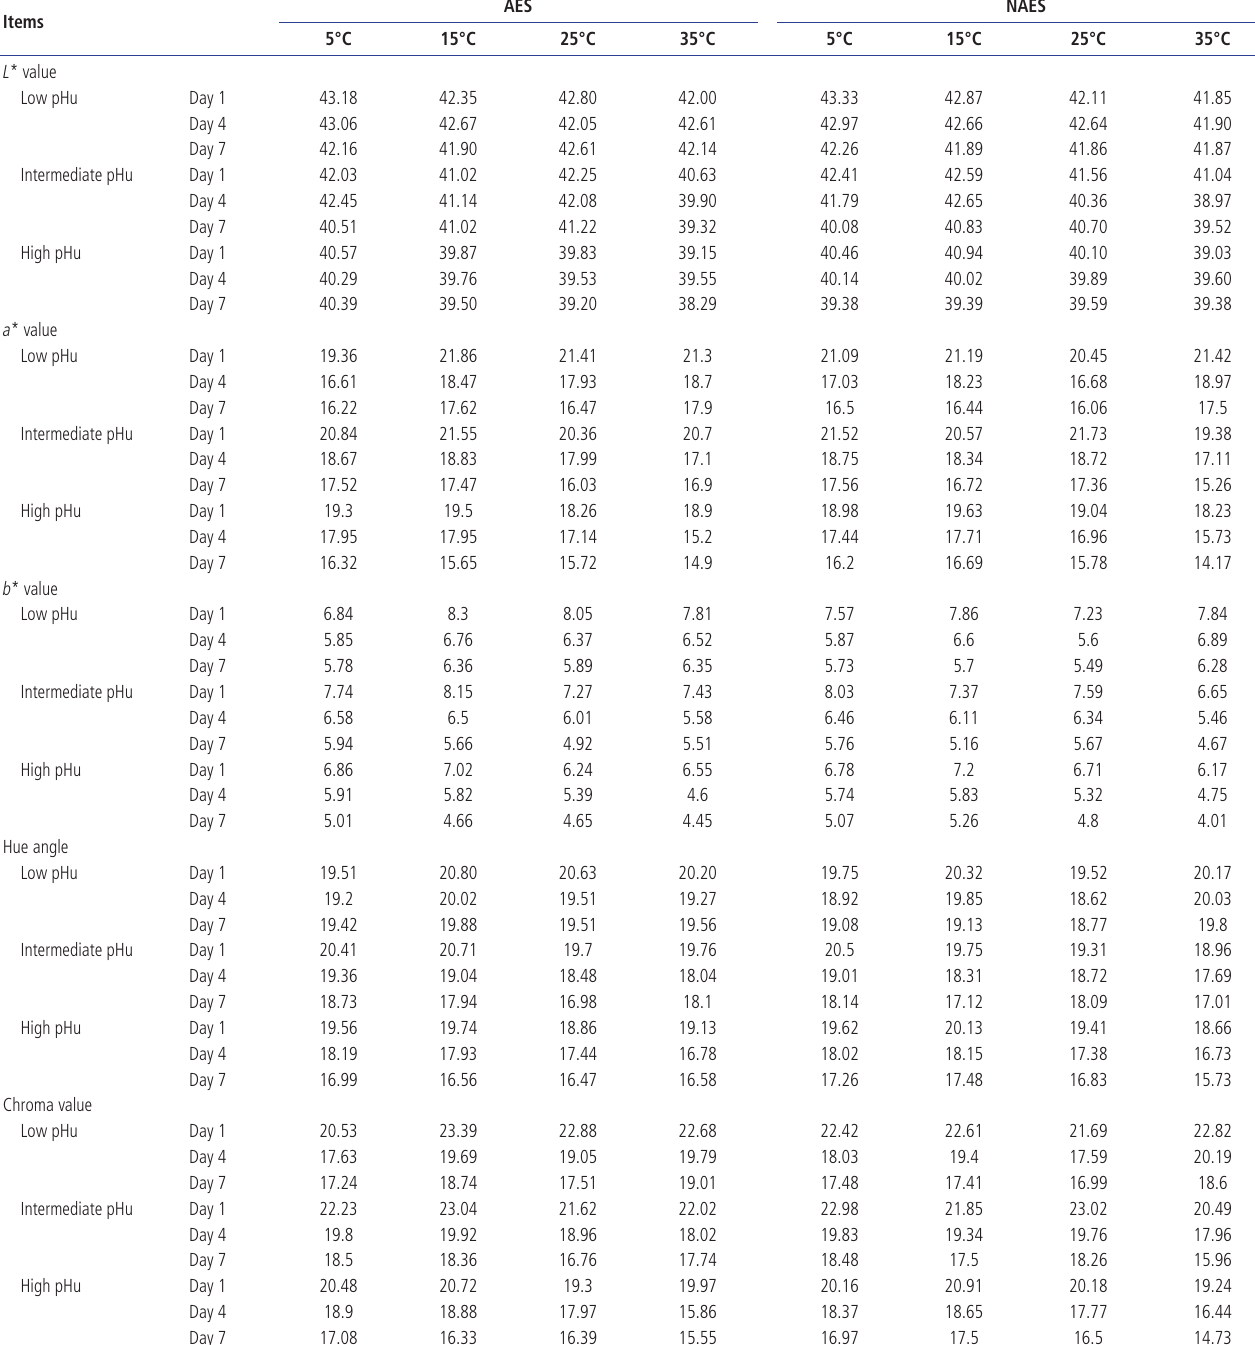
Table 4. Effect of AES and various pre-rigor holding temperature (for 3 h) methods on the lightness, redness and yellowness (48 h post mortem) of low, intermediate and high pHu beef M. longissimus lumborum samples